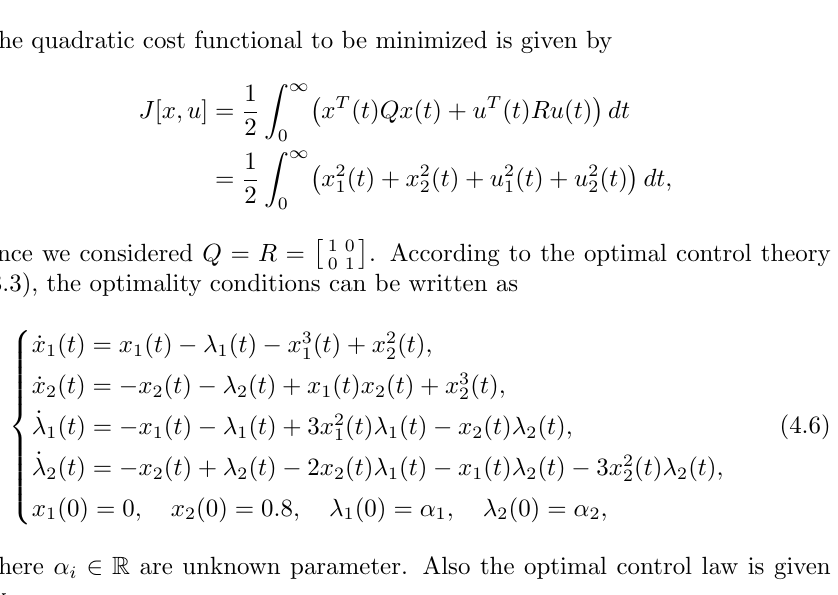
Figure 5. Comparison the bvp4c , modal series method and PADM ( m = 2, M = 50) approximate solution of x 3 ( t ), u 3 ( t